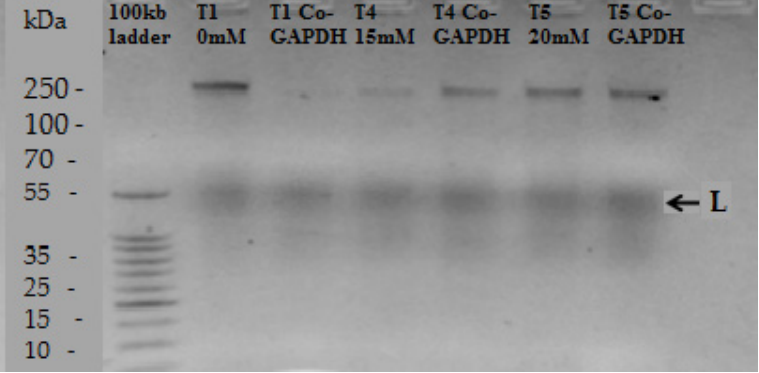
Figure 7. Qualitative expression of the Rubisco when viewed under gel electrophoresis in leaf of F. deltoidea.